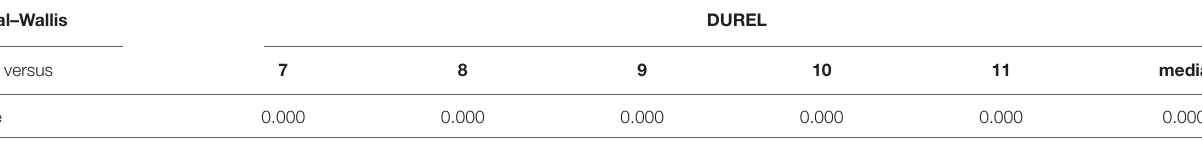
TABLE 8 | Kruskal–Wallis test - religious affiliation and students’ religiosity Duke University Religious Index